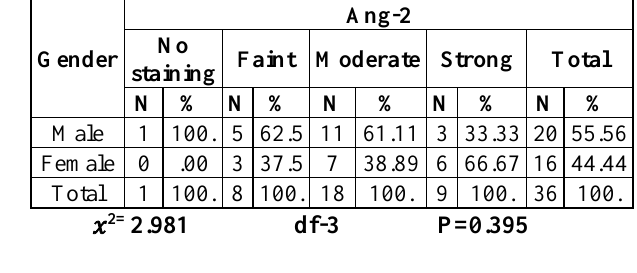
Table 6: The association between Ang-2 expression and Clinical presentation of